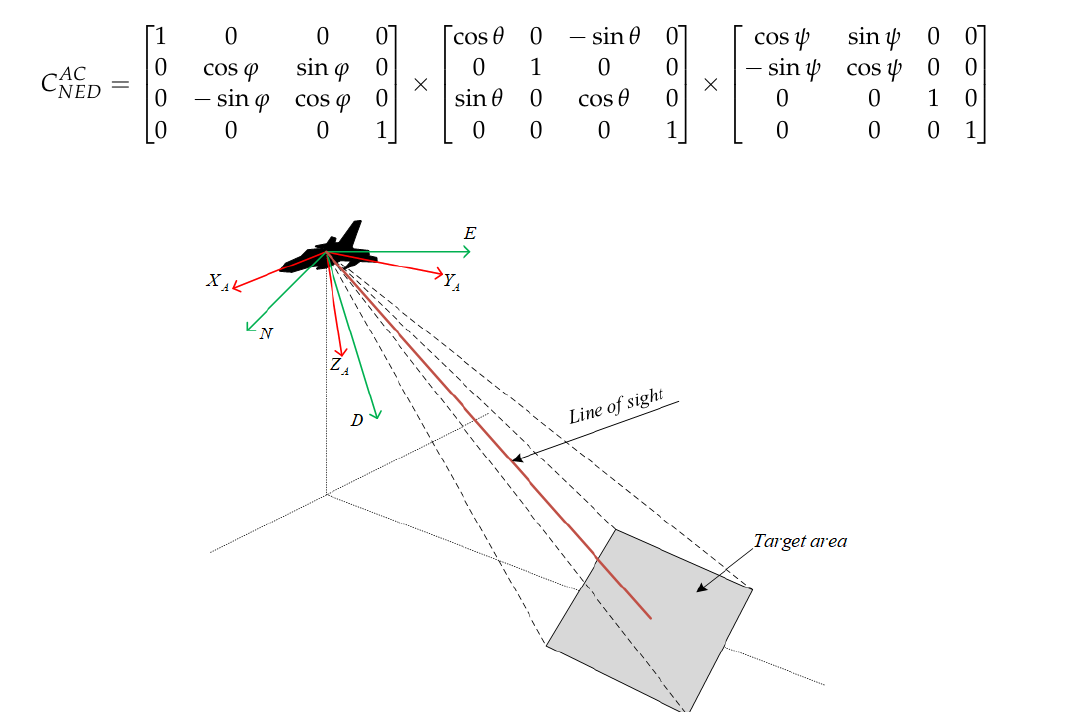
Figure 4. Schematic of NED coordinate system and AC coordinate system.